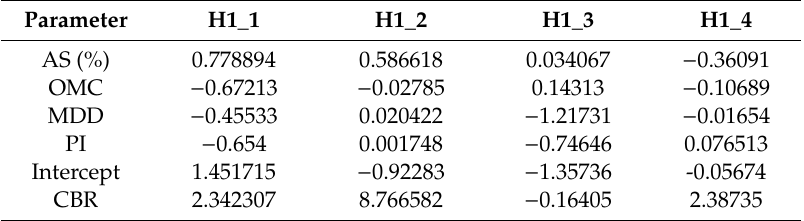
Table 5. Parameter estimates of ANN models for CBR